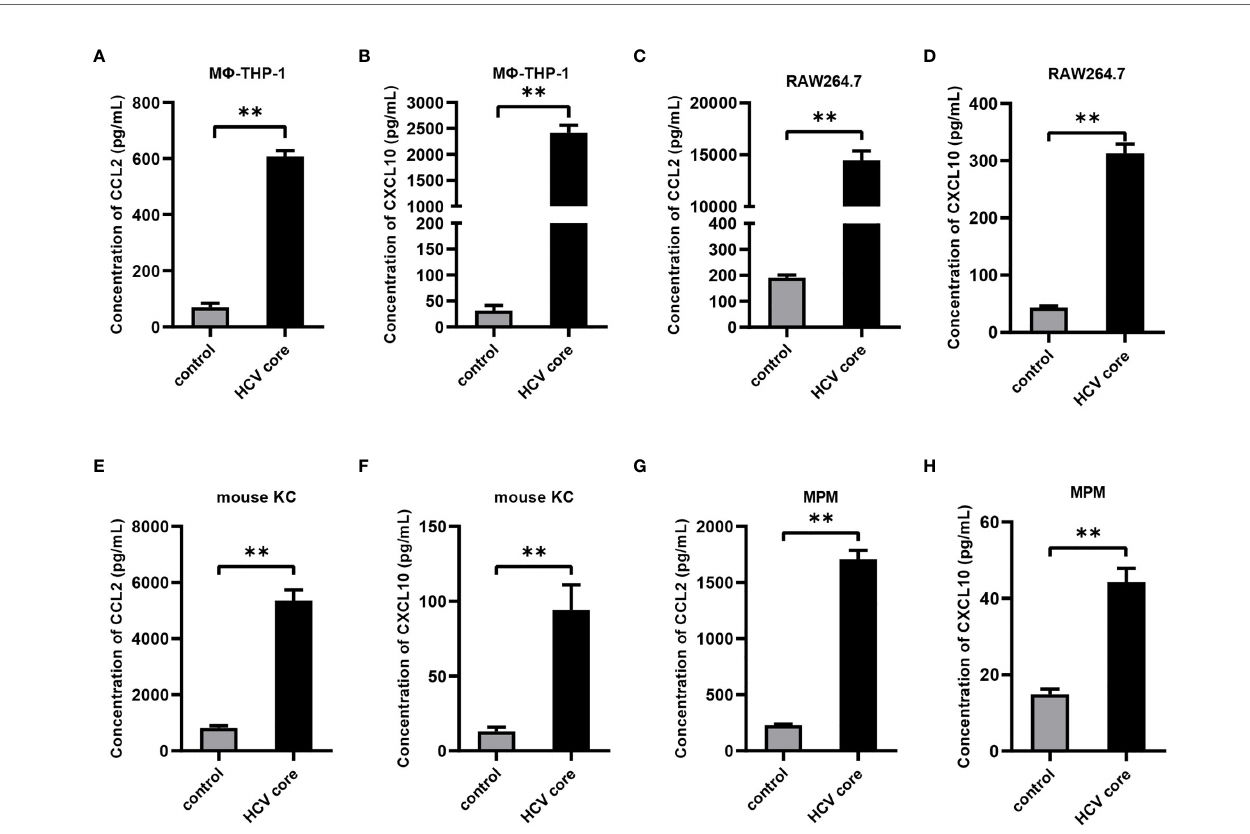
FIGURE 2 | HCV core protein up-regulates CCL2 and CXCL10 expression in macrophages. Human macrophages cell line (M F -THP-1) (A, B) , mouse macrophage cell line RAW 264.7 (C, D) , mouse Kupffer cells (KC) (E, F) and mouse peritoneal macrophages (MPM) (G, H) were treated or untreated with HCV core protein (10 m g/mL) for 24 h. Cell culture supernatants were collected and analyzed for CCL2 and CXCL10 production using ELISA kits. Data are shown as mean ± SD for three independent experiments. ** p <